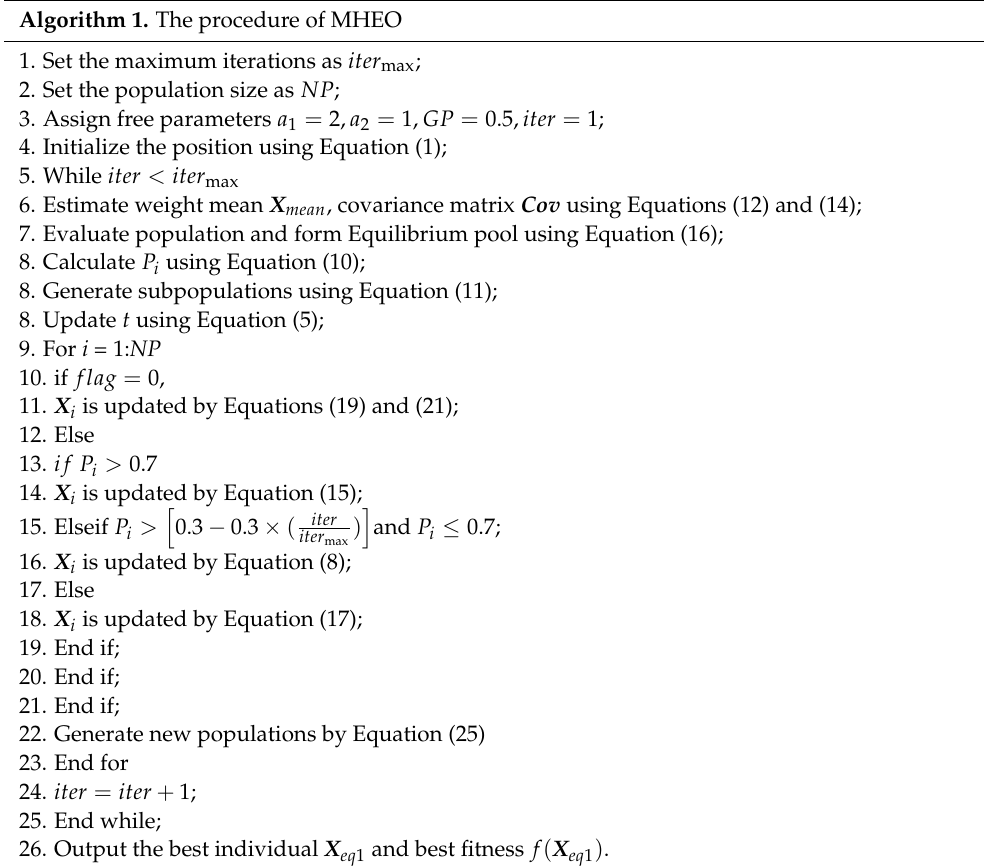
Algorithm 1. The procedure of